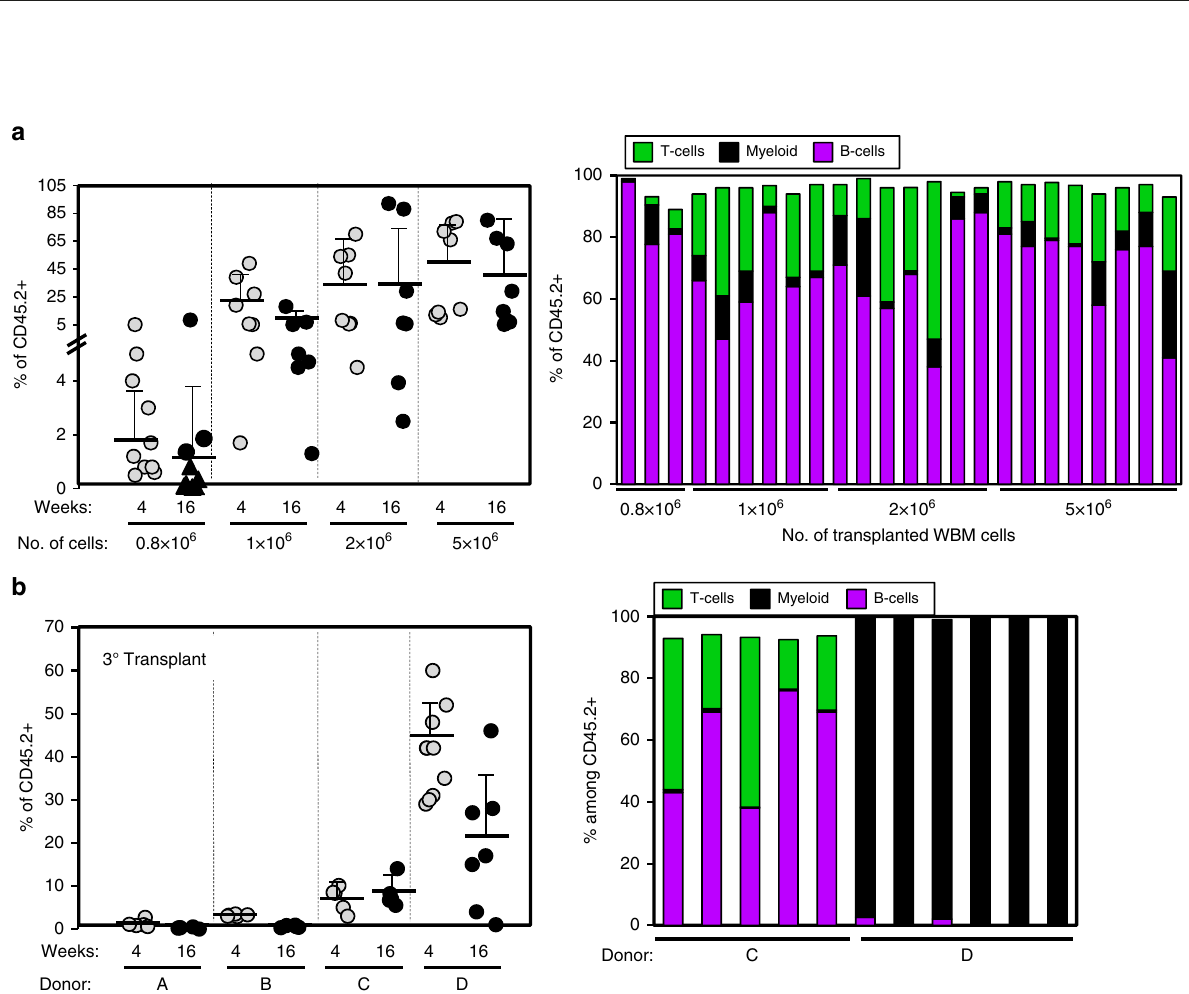
Fig. 2 Pre-circulation Em-Ex display serially transplantable multi-lineage potential. a Left panel: Total WBM was isolated from three primary recipients of CD45.2 + 5 – 7sp Em-Ex-derived cells and transplanted separately into three secondary cohorts of lethally irradiated CD45.1 + CD45.2 + recipients. Mice received 0.8 × 10 6 ( n = 9), 1 × 10 6 ( n = 7), 2 × 10 6 ( n = 8) or 5 × 10 6 ( n = 8) total WBM cells. Data pooled from three independent experiments is shown. Non-engrafted mice are depicted as triangles. Means are shown. Error bars denote standard deviation. Right panel: Frequency of myeloid cells, T cells and B cells in CD45.2 + PB of secondary recipients of 5 – 7sp Em-Ex 16 weeks post-transplant. b 5 × 10 6 WBM cells from secondary recipients of 5 – 7sp Em-Ex were transplanted into CD45.1 + CD45.2 + mice along with 2 × 10 5 CD45.1 + WBM cells. Bone marrow from n = 4 independent secondary recipients were transplanted into independent cohorts of tertiary recipients. Secondary donors A, B, and C derived from the same initial primary recipient. Secondary donor D derived from an independent primary recipient. Left panel: %CD45.2 + tertiary recipient PB cells. Four (white circles) and 16 (black circles) weeks post- transplant. Donors A, B, and C ( n = 5 recipients); Donor D ( n = 10 recipients). Each circle indicates an independent tertiary recipient. Means and standard deviations are depicted. Right panel: Frequency of myeloid cells, T cells and B cells in CD45.2 + PB of tertiary recipients 16 weeks post-transplant. Each column corresponds to an independent recipient. Source data are provided as a Source Data fi le